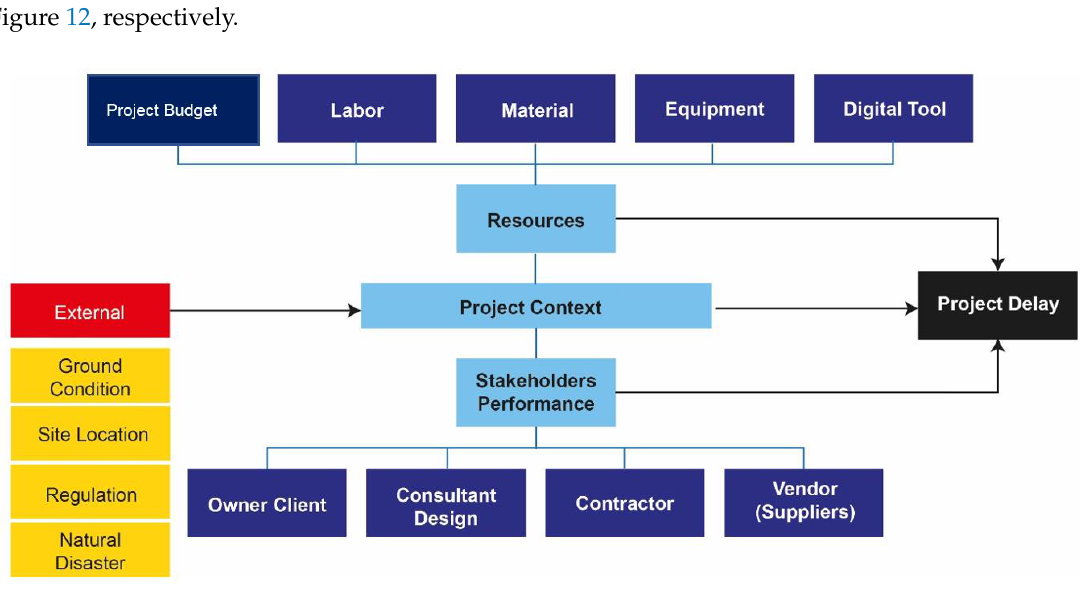
Figure 12. The DEC conceptual model including main constructs of resources, project context, and stakeholders.